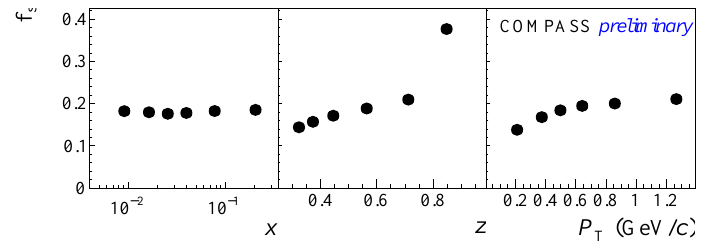
Figure 2: The ρ 0 signal fraction as function of x (left plot), z (middle plot) and P (right